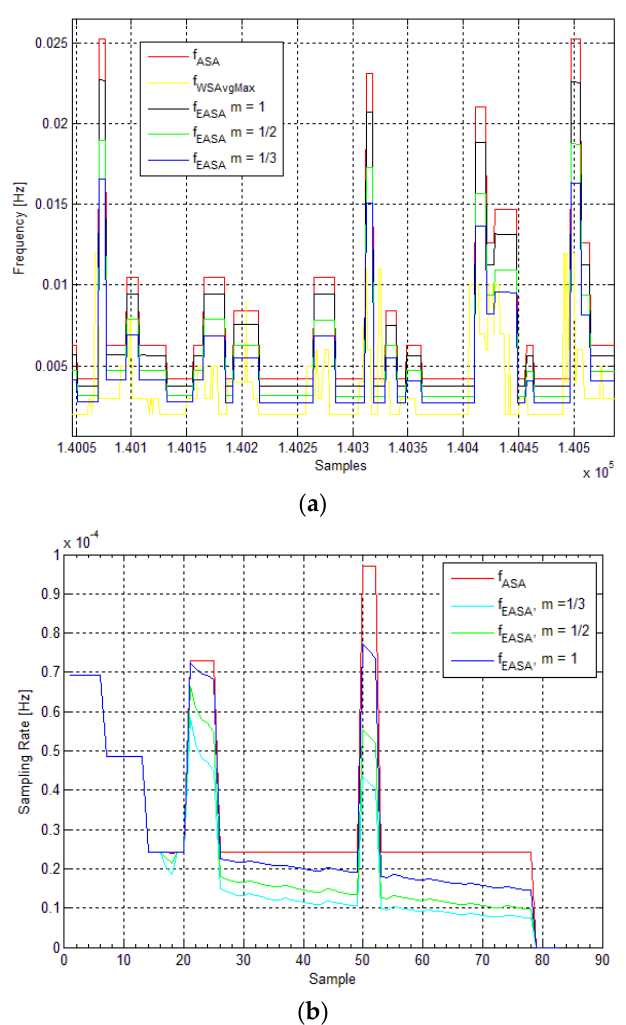
Figure 8. ( a ) Deployment (I): Sampling rates and maximum frequency of the average wind speed signal vs. samples; ( b ) Deployment (II): Sampling rates and maximum frequency of the average wind speed signal vs. samples.